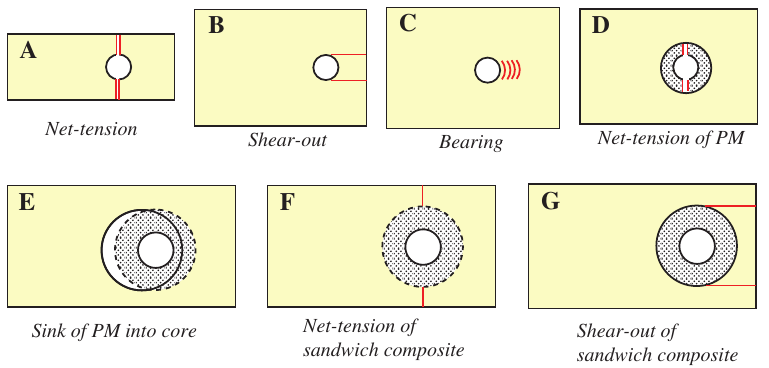
Figure 6 Typical damage modes of foam-based sandwich composites with and without the potting materials (PM).